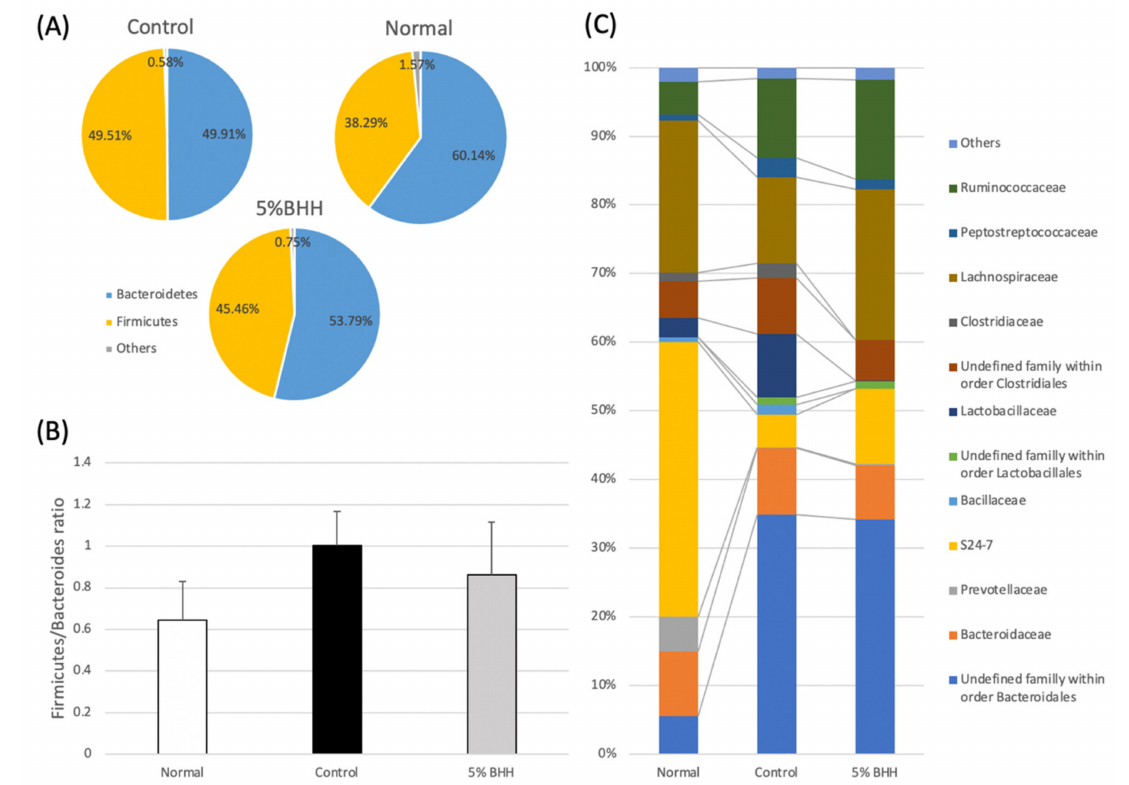
Figure 5. Differential bacterial community on the phylum-level ( A ), Firmicutes / Bacteroidetes ratio ( B ), and differential bacterial community on the family-level ( C ) among each treatment group, Normal, Control, and 5% BHH. Error bars represent the mean ± standard deviation. Others in ( A ) contained Actinobacteria , Proteobacteria , Spirochaetes , Tenericutes , and undefined bacteria on the kingdom